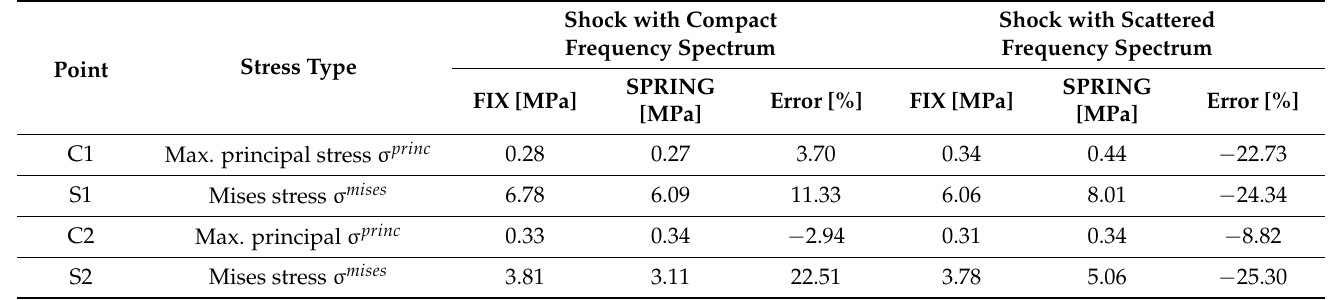
Table 7. Mining induced stress: maximum values referred to the events with compact and scattered frequency.